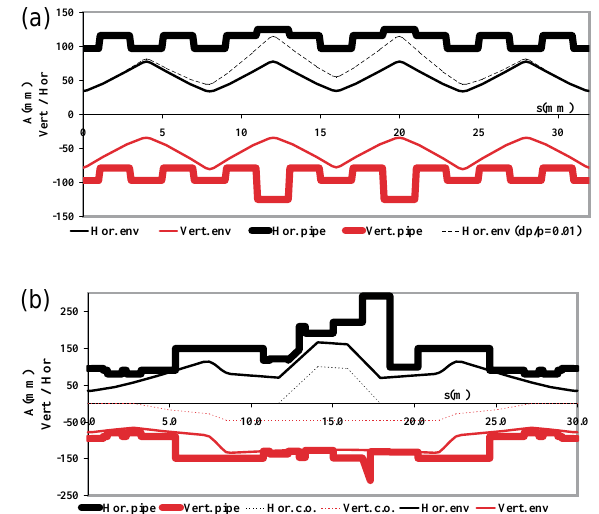
FIG. 1. (Color) Physical aperture and beam envelope at 480 p mm mrad. The thick lines correspond to the vacuum pipe. Top: arc aperture. The dashed line corresponds to d p (cid:1) p 0 (cid:1) 1% . Bottom: injection straight section. The dashed line is the closed orbit given by the painting bumps for a full beam. On each plot, the upper half corresponds to the horizontal plane while the vertical plane is plotted as a negative value. the vacuum pipe and the lattice functions. The maximum acceptance available is calculated for protons with uncou- pled motion in the horizontal and vertical planes. For sec- ondary halo, the particle motion is likely to be coupled because of isotropic scattering and because the oscillation occurs at high amplitudes. We calculate the minimum hori- zontal A x and vertical A y acceptance as well as the com- bined one A xy (cid:1) A x 1 A y . Dispersion is taken into account with a momentum devi- (cid:1) 6 1% corresponding to the bucket accep- ation dp (cid:1) p 0 tance. Results of the acceptance calculations are shown in Table I. For a momentum deviation of 6 1% , the minimum acceptance is found in the center of the arc dipole where the dispersion h x and betatron amplitude b y have an ab- solute and local maximum, respectively. The minimum acceptance value (around 520 p ) is still over the secondary halo maximum extent allowing a clean removal of the halo. For momentum cleaning, we require a momentum ac-